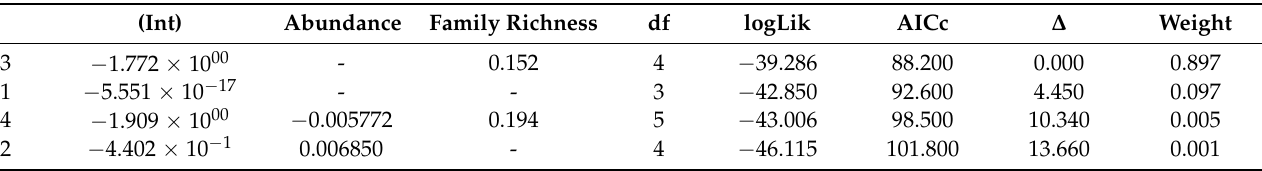
Table A5. Fennel essential oil yield model selection based on the comparison of their corrected Akaike